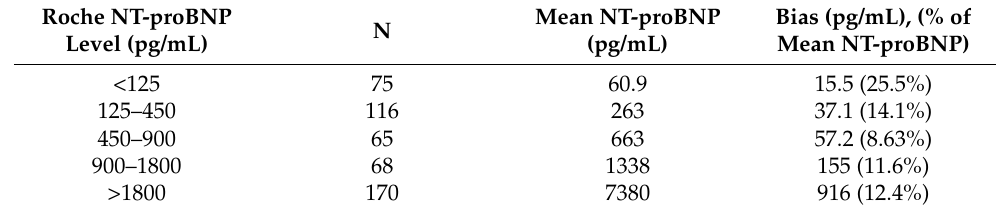
Table 1. Bias as a percentage of the mean NT-proBNP at different levels of Roche NT-proBNP. Roche